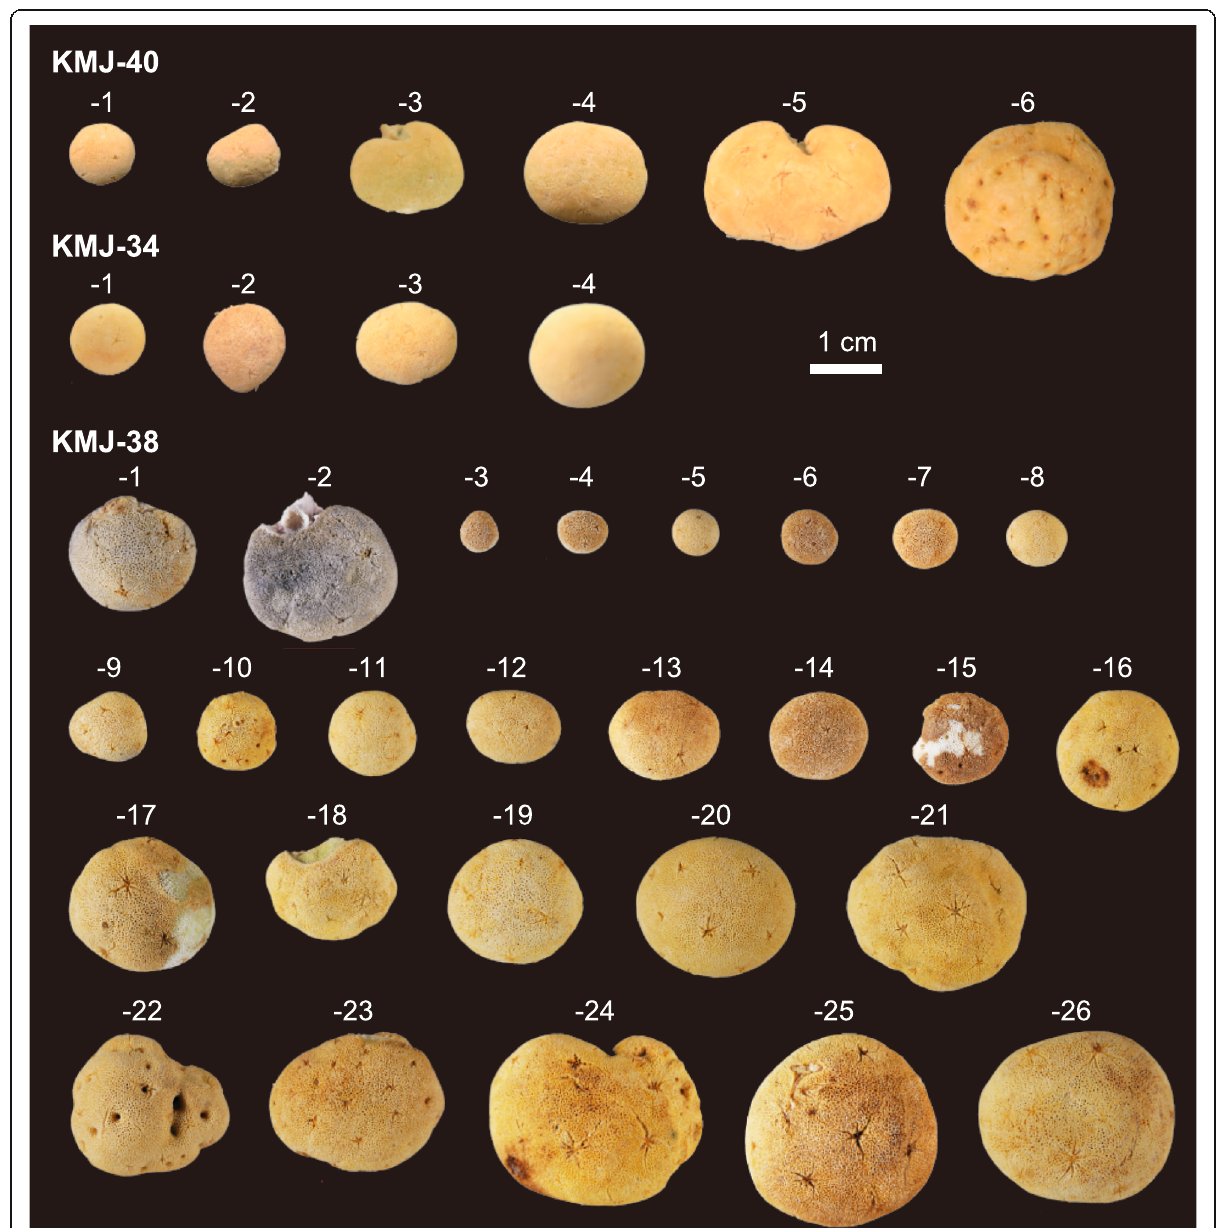
Fig. 3 Photographs of sclerosponge